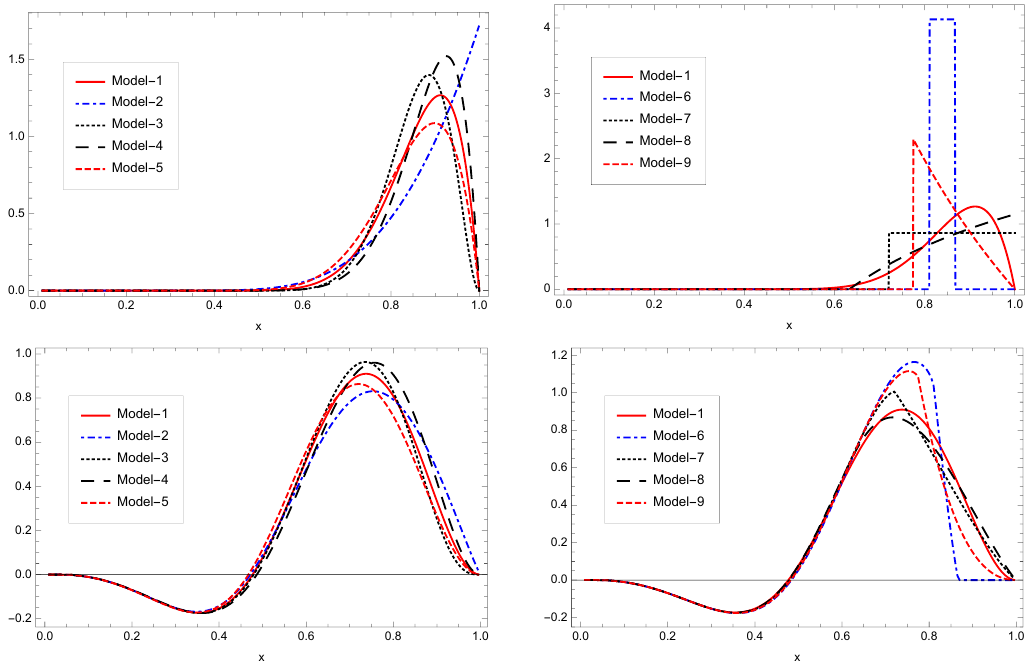
Figure 4 . The first row shows the different models, the corresponding SGDs at LO are given in the second